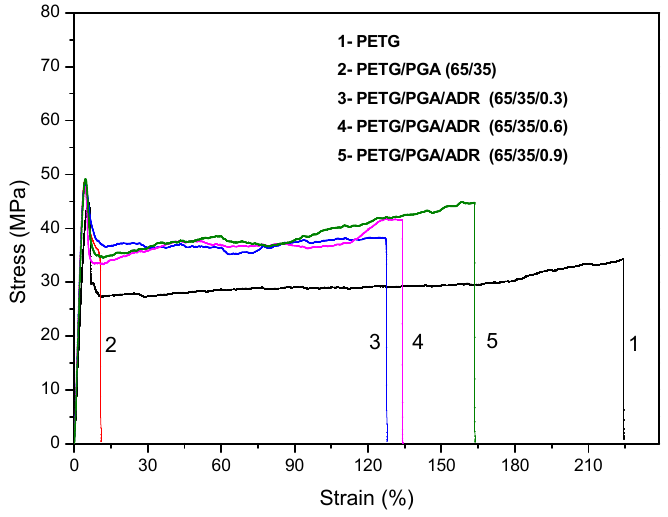
Figure 10. Tensile stress–strain curves for neat PETG and PETG/PGA/ADR (65/35/x) samples.